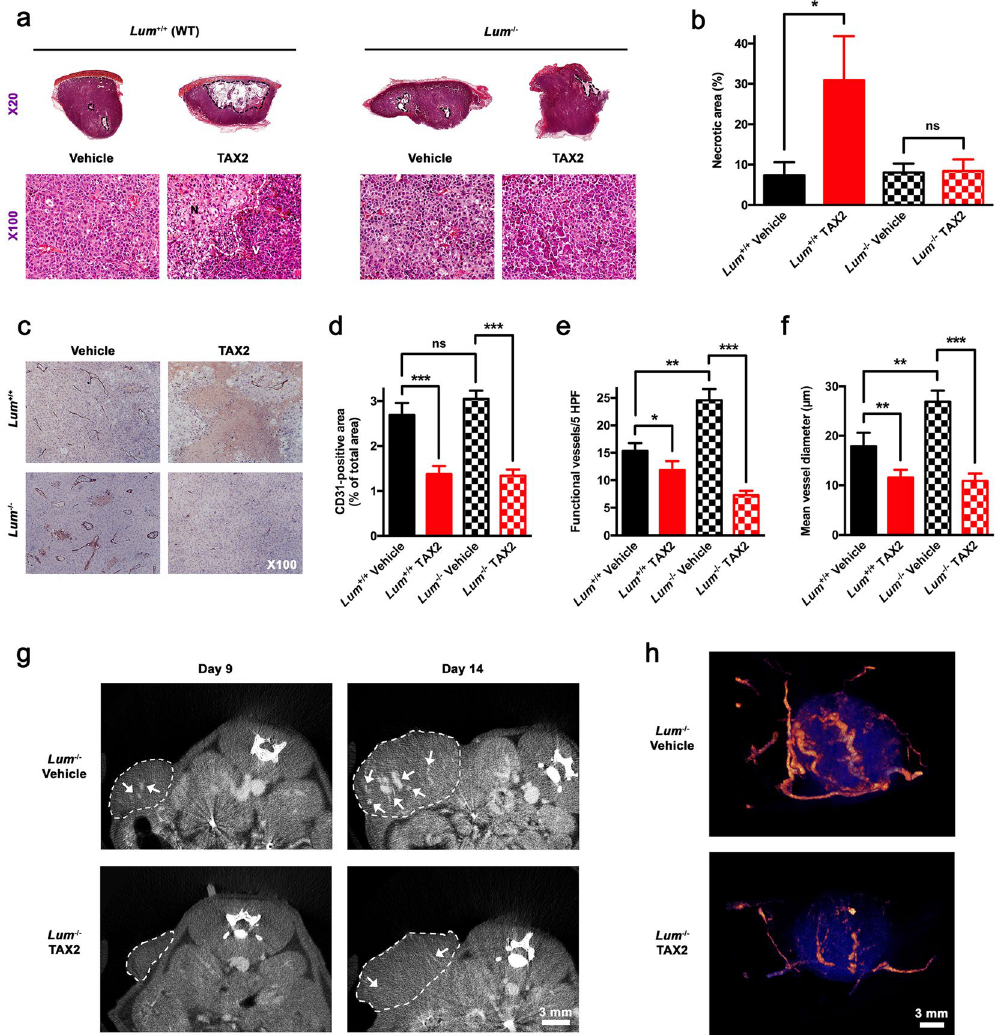
Figure 4. Analysis of s.c. melanoma tumor necrosis and vascularization. ( a ) Macroscopic views (x20 magnification, top panel ) of HES-stained sections showing areas of tumor necrosis ( black dotted lines ). Lower panel ( × 100 zoom) highlights delimitation ( white dotted line ) between viable tumor tissue (V) and cellular debris within necrotic area (N). ( b ) Quantification of tumor necrosis relative to total tumor surface (mean ± SEM, t test, ns not significant, * p < 0.05). ( c ) CD31 immunostainings of tumor sections ( × 100). ( d – f ) Quantification of ( d ) relative CD31-positive area, ( e ) number of functional blood vessels in five high power fields (HPF, × 100) and ( f ) mean vessel diameter (mean ± SEM, t test, ns not significant, * p < 0.05, ** p < 0.01, *** p < 0.001). All quantitative analyses were performed using ImageJ software and considering five random fields per animal. ( g ) Longitudinal follow-up of tumor angiography through µ CT analysis. Dotted lines delimitate s.c. tumors while arrows illustrate contrast enhancement of intratumoral blood vessels. ( h ) Tridimensional reconstructions of tumors imaged on day 14. Melanoma tumor ( blue ) and the associated vascular network ( orange ) were segmented using Amira 5.4.3